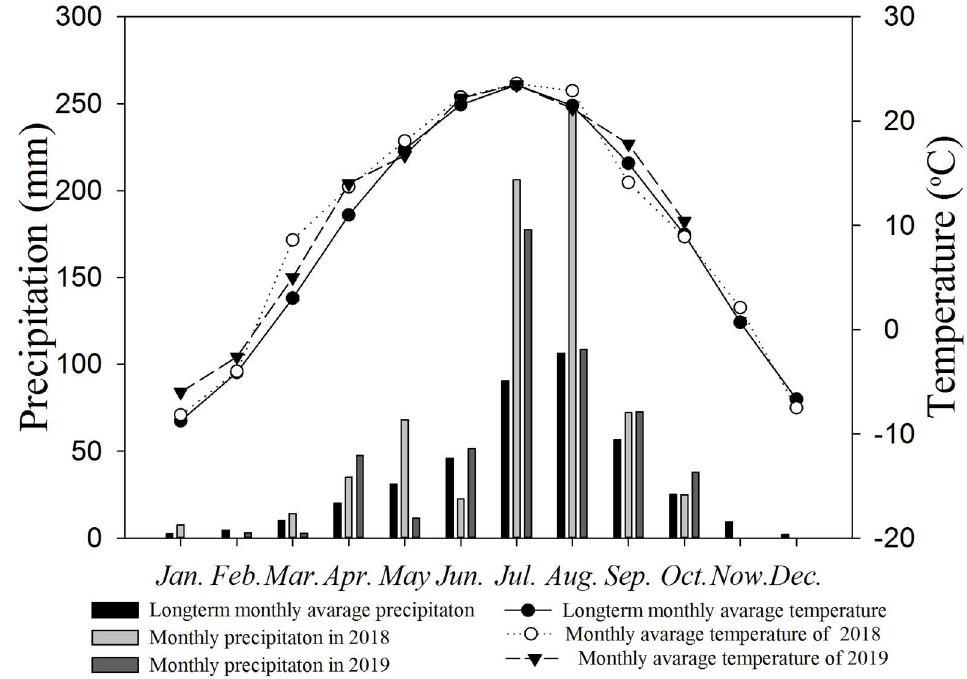
Figure 1. Monthly and long-term averages of precipitation and temperature at the experimental site. Table 1. The experiment design in this study.